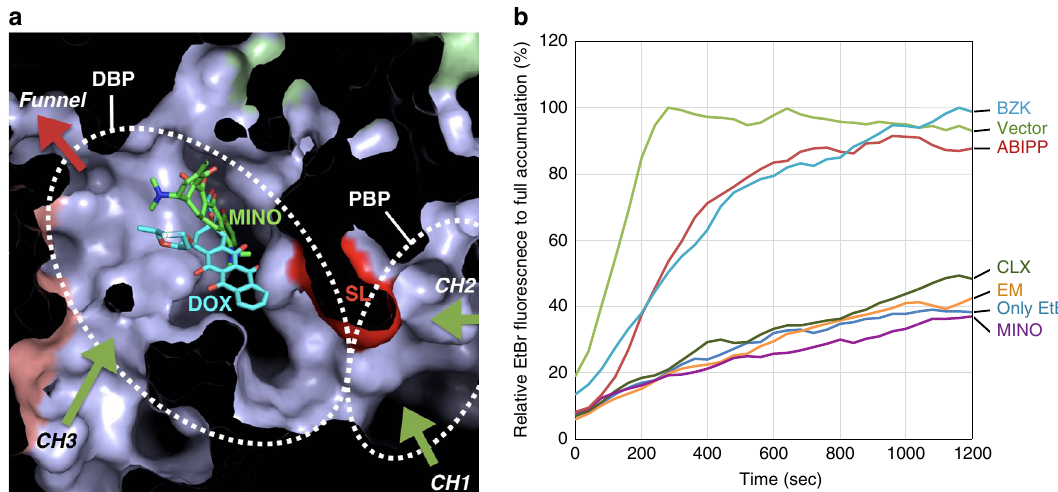
Fig. 3 Competitive inhibition of several AcrB substrates on ethidium bromide ef fl ux. a Cut side-view of the porter region of the binding monomer of AcrB, magni fi ed around the drug-binding pockets and the intramolecular channels. DBP-bound minocycline (MINO, green sticks) and doxorubicin (DOX, cyan sticks) are superimposed. b Ethidium bromide (10 μ M ) competition fl uorescence assay in combination with several substrates (100 μ M ) or the inhibitor ABI-PP (32 µ g ml − 1 ). The vertical axis shows the percentage of fl uorescence compared to full accumulation in acrB -knockout E. coli cells. EM erythromycin, MINO minocycline, CLX cloxacillin, BZK benzalkonium. Shown is one of the results, repeats of the experiment gave similar